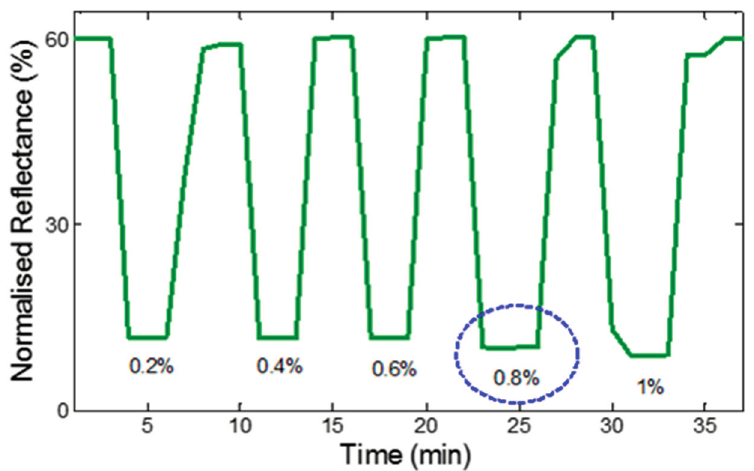
Figure 12. Resolution of the developed fiber sensor.